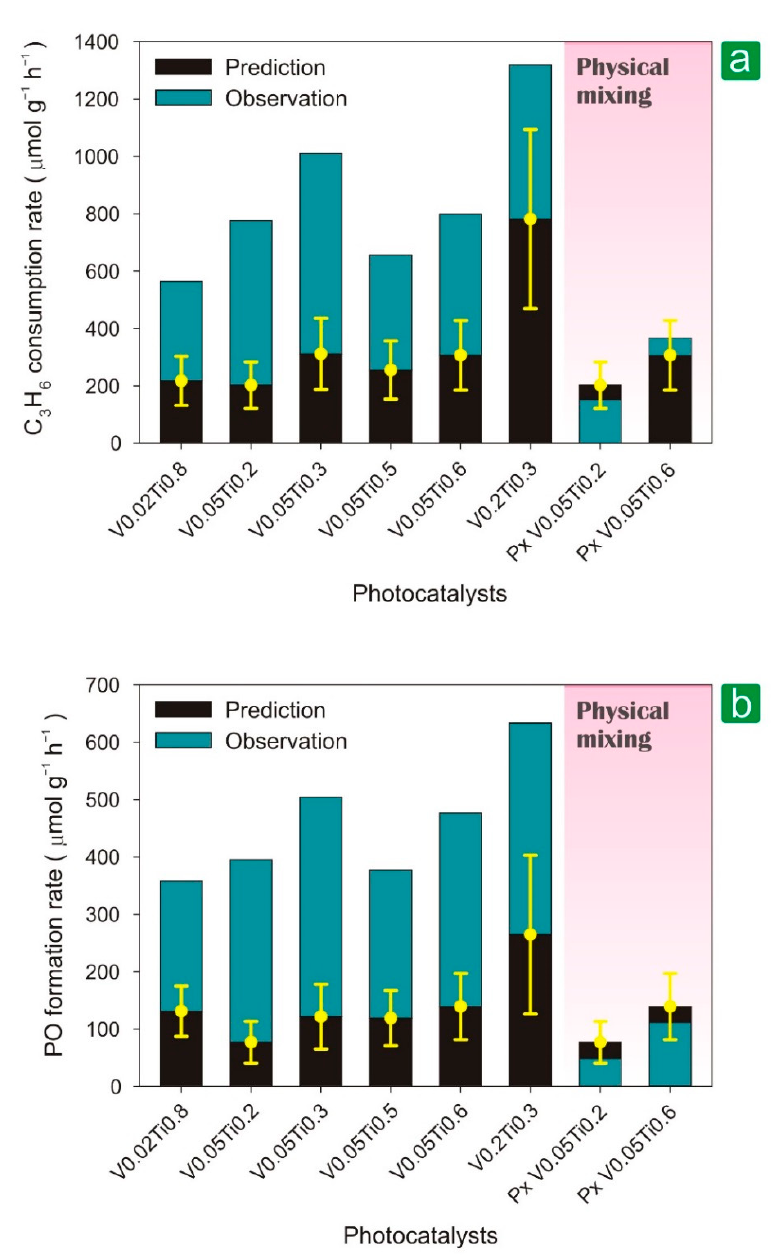
Figure 3. Contribution activity analysis for ( a ) C 3 H 6 consumption and ( b ) PO formation rates. Reproduced with permission from [6] .